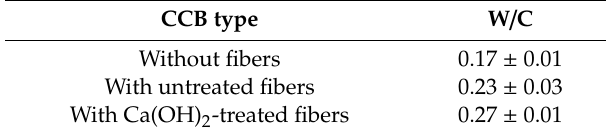
Table 3. Water / cement ratios (W / C) of di ff erent composite cement boards (CCB).